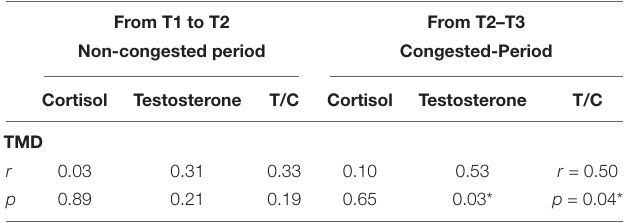
TABLE 9 | Relations between hormonal parameters and psychological